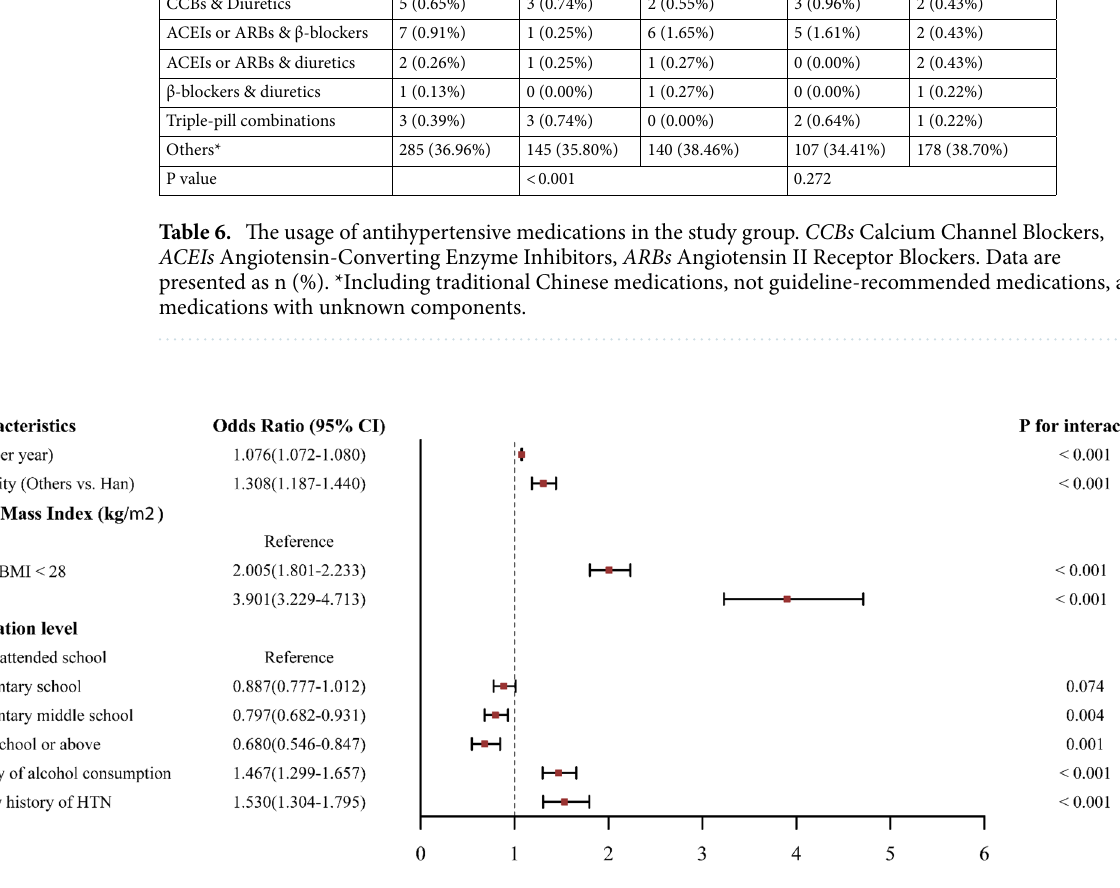
Figure 2. Multiple factors of HTN for the study